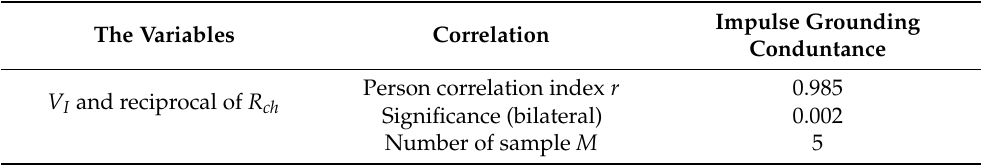
Table 2. V I and reciprocal of R ch of different soil resistivity.